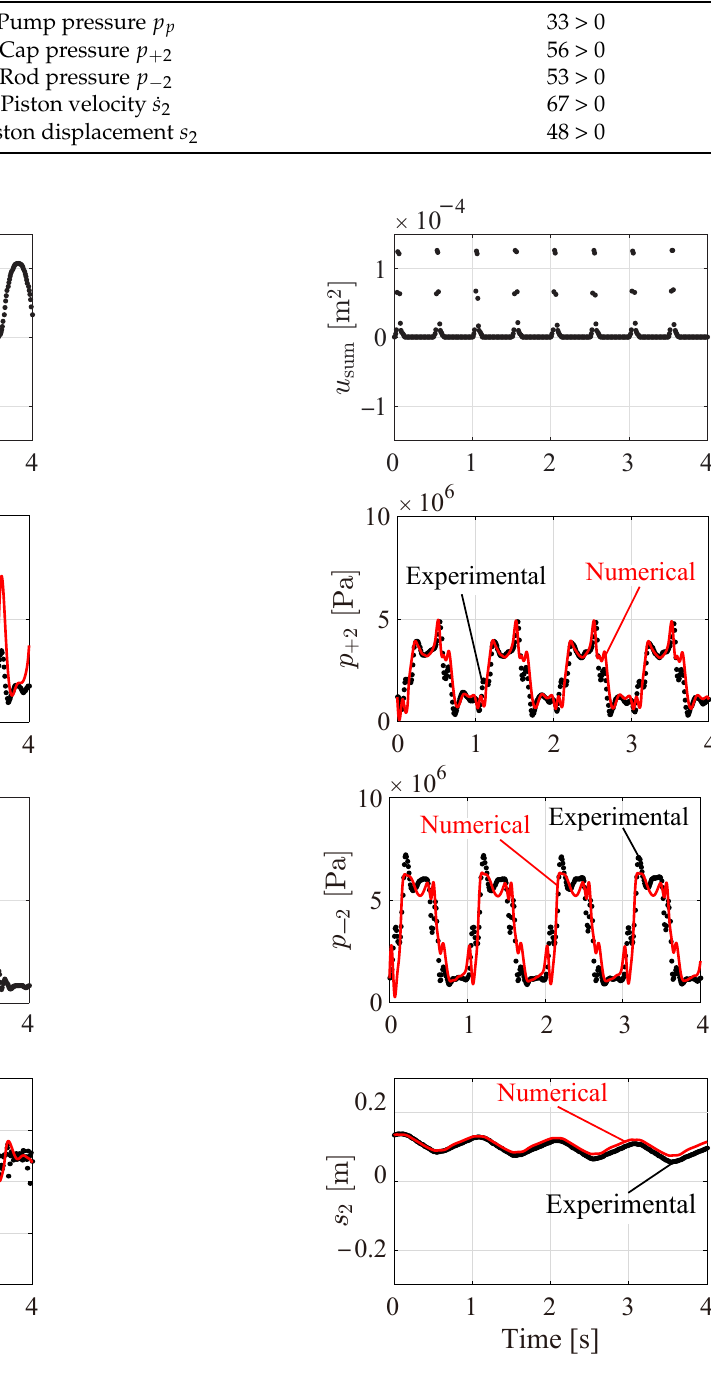
Figure 8. Input u 2 and the outputs (cross validation, f = 1.0 [Hz], joint